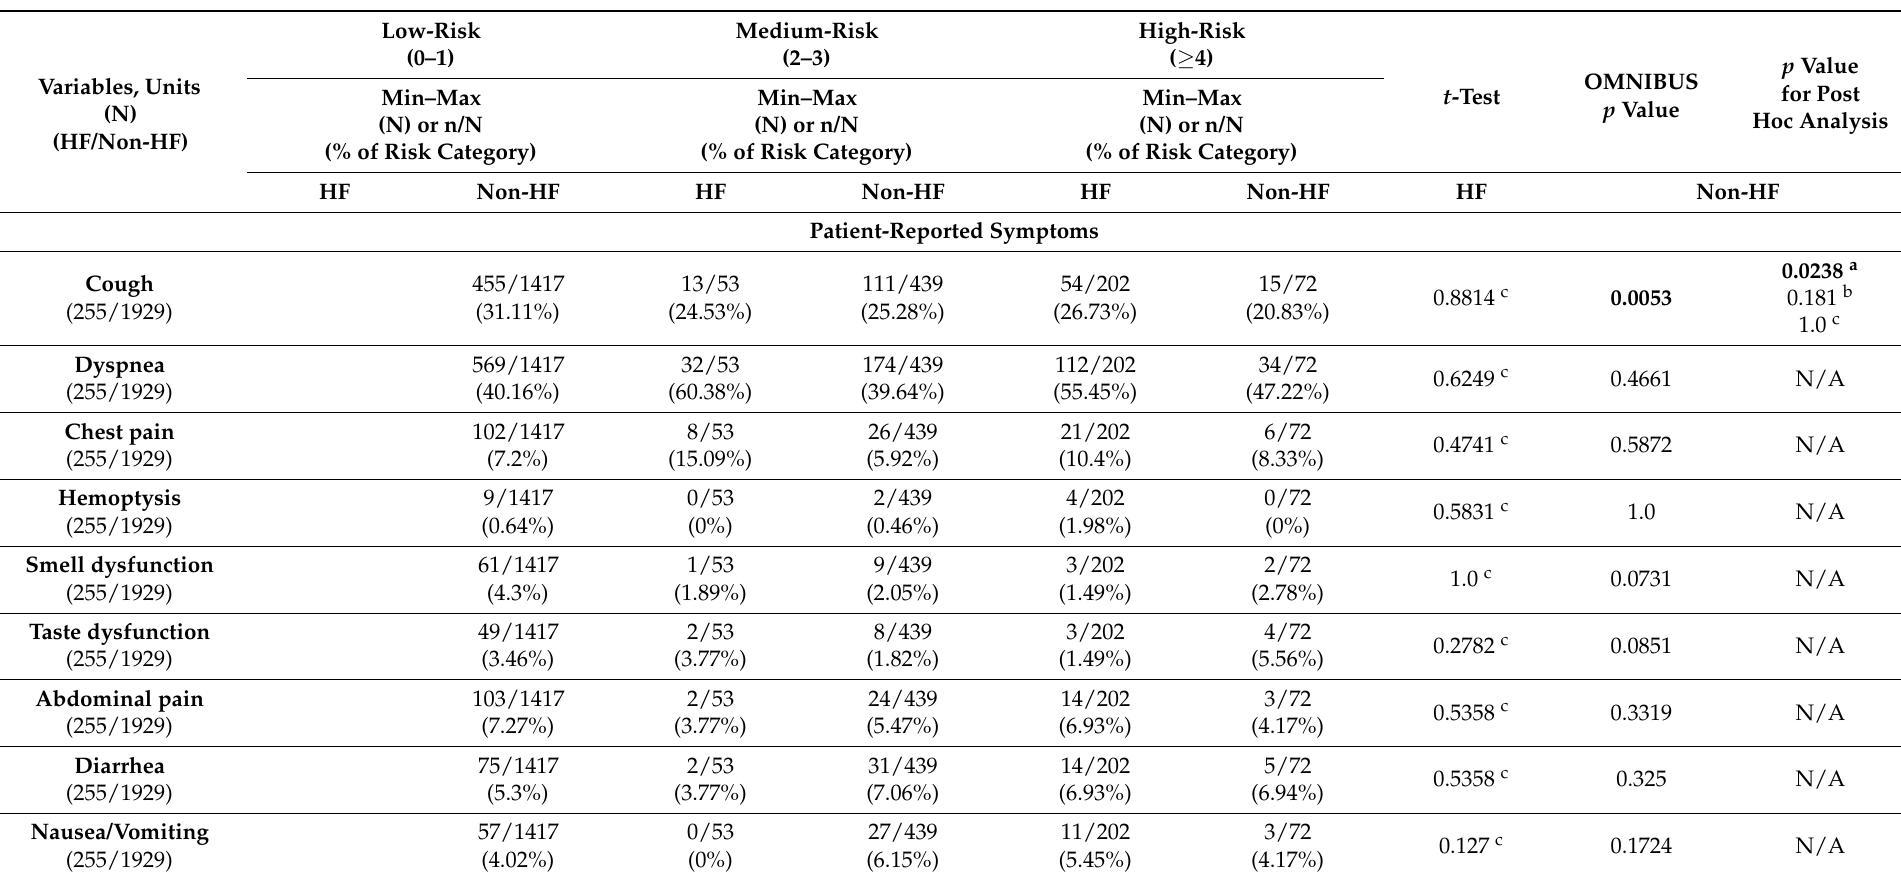
Table 2. Patient-reported symptoms, vital signs, and abnormalities measured during physical examination at hospital admission in the HF and non-HF study cohorts after C 2 HEST risk